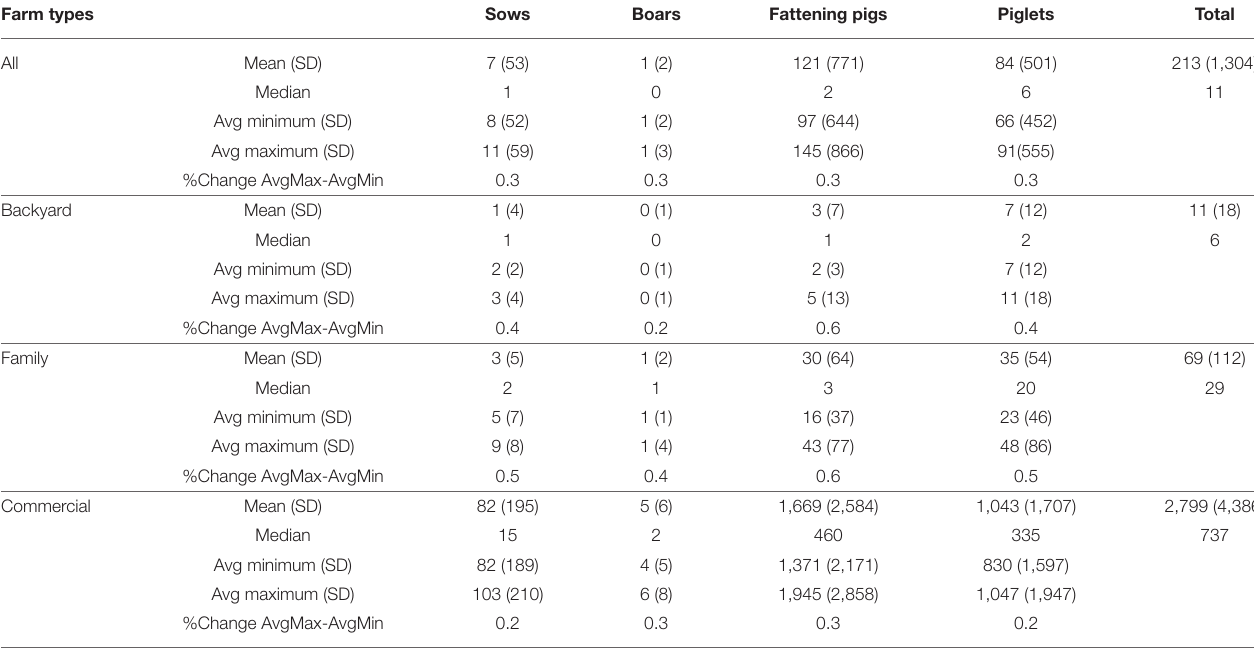
TABLE 1 | Number of pigs by farm type as reported by questionnaires administered to North Macedonian pig producers between September 2019 and March 2020. Farm